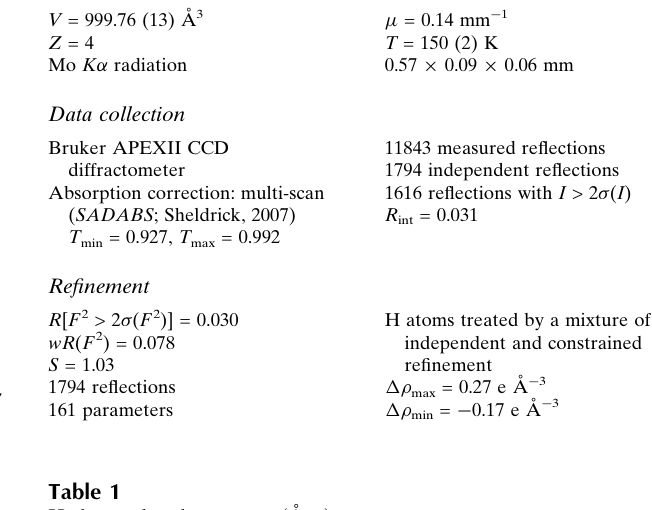
Hydrogen-bond geometry (A˚ , (cid:1)